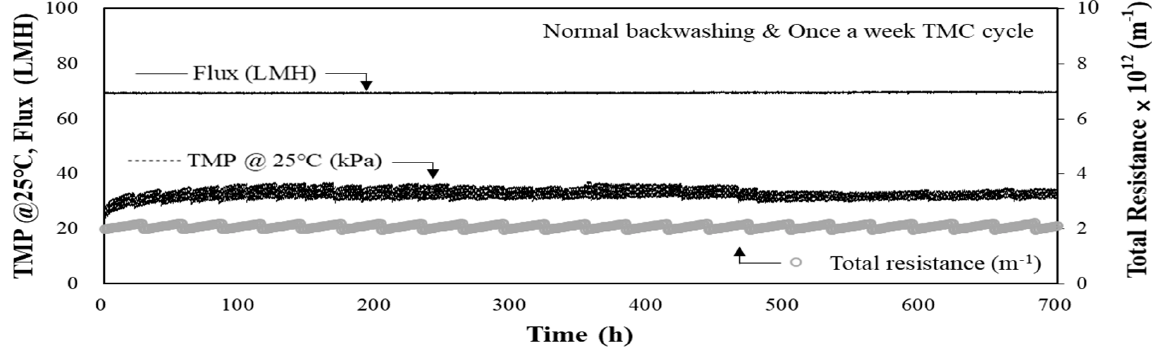
Figure 3. TMP and total resistance during the operation of MF-alone process with low-turbidity raw water (max. turbidity = 11.1 NTU, flux = 70 LMH).